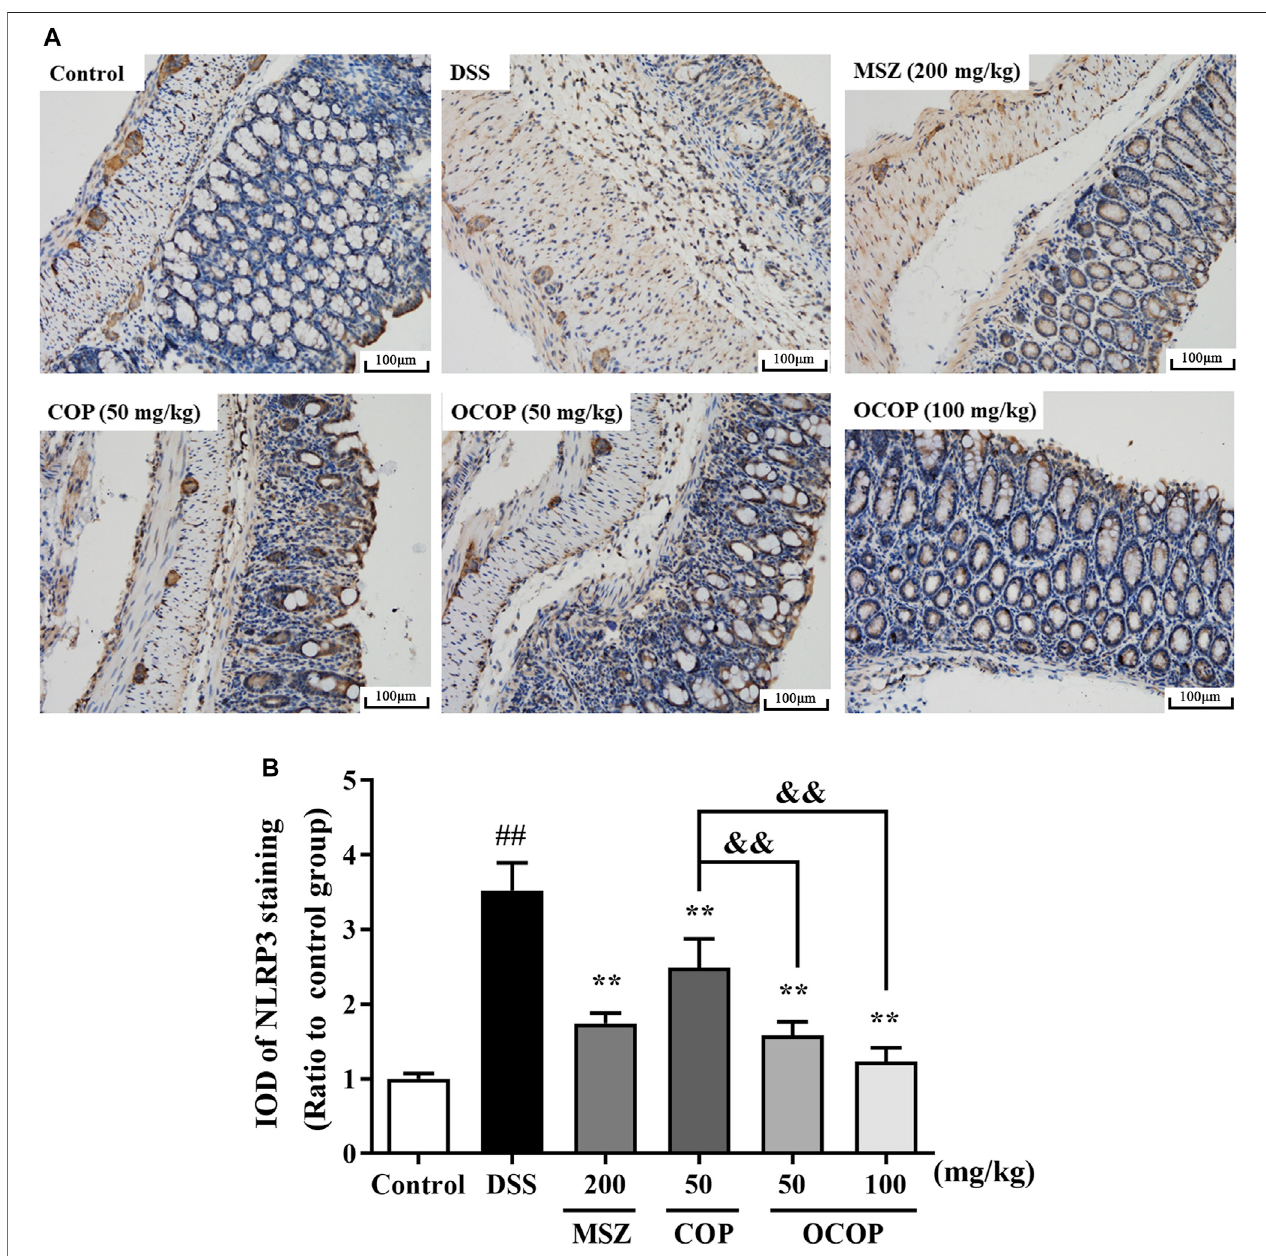
FIGURE 7 | (A) Representative photographs of p65 immunohistochemical staining (magni fi cation × 200) (B) Integrated optical density of p65. Data are expressed as the means ± SD (n (cid:2) 3). # p < 0.05, ## p < 0.01 vs. control group; * p < 0.05, ** p < 0.01 vs. DSS group; & p < 0.05, && p < 0.01 vs. COP group.